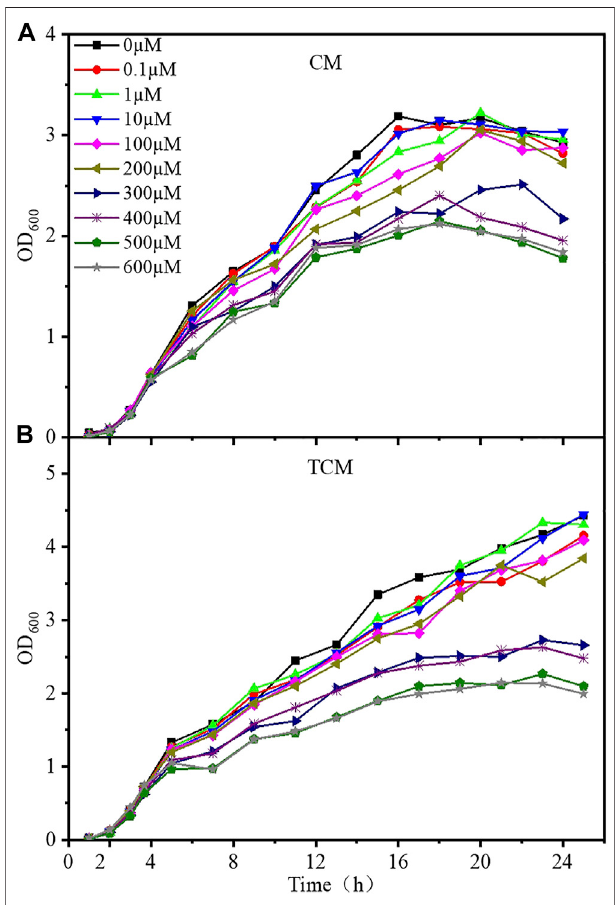
FIGURE 2 | Growth curves of the two WCB sensor strains at various Cd 2+ concentrations. (A) Without negative feedback, WCB CM; (B) With negative feedback, WCB TCM.